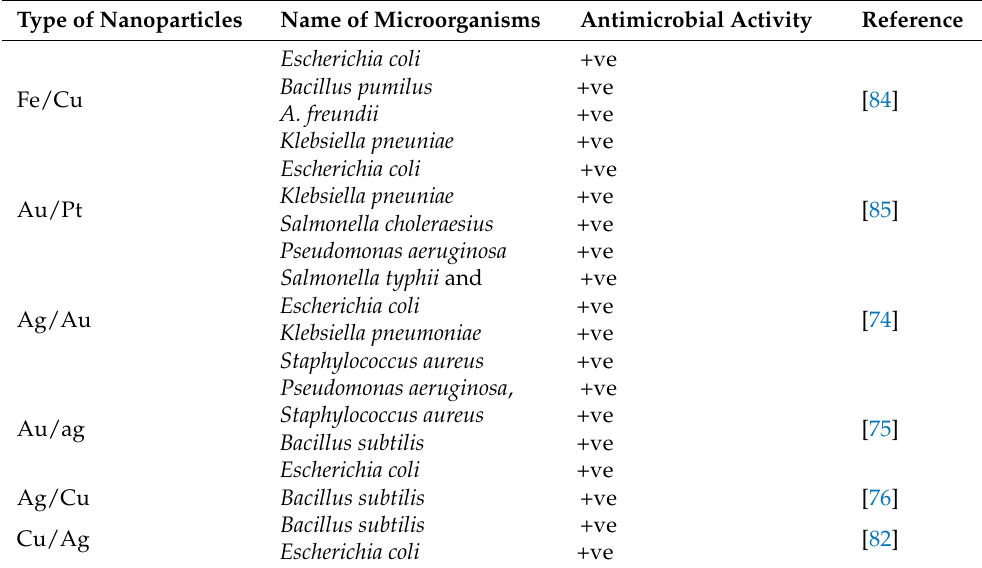
Table 4. Antibacterial activities of different bimetallic nanoparticles.